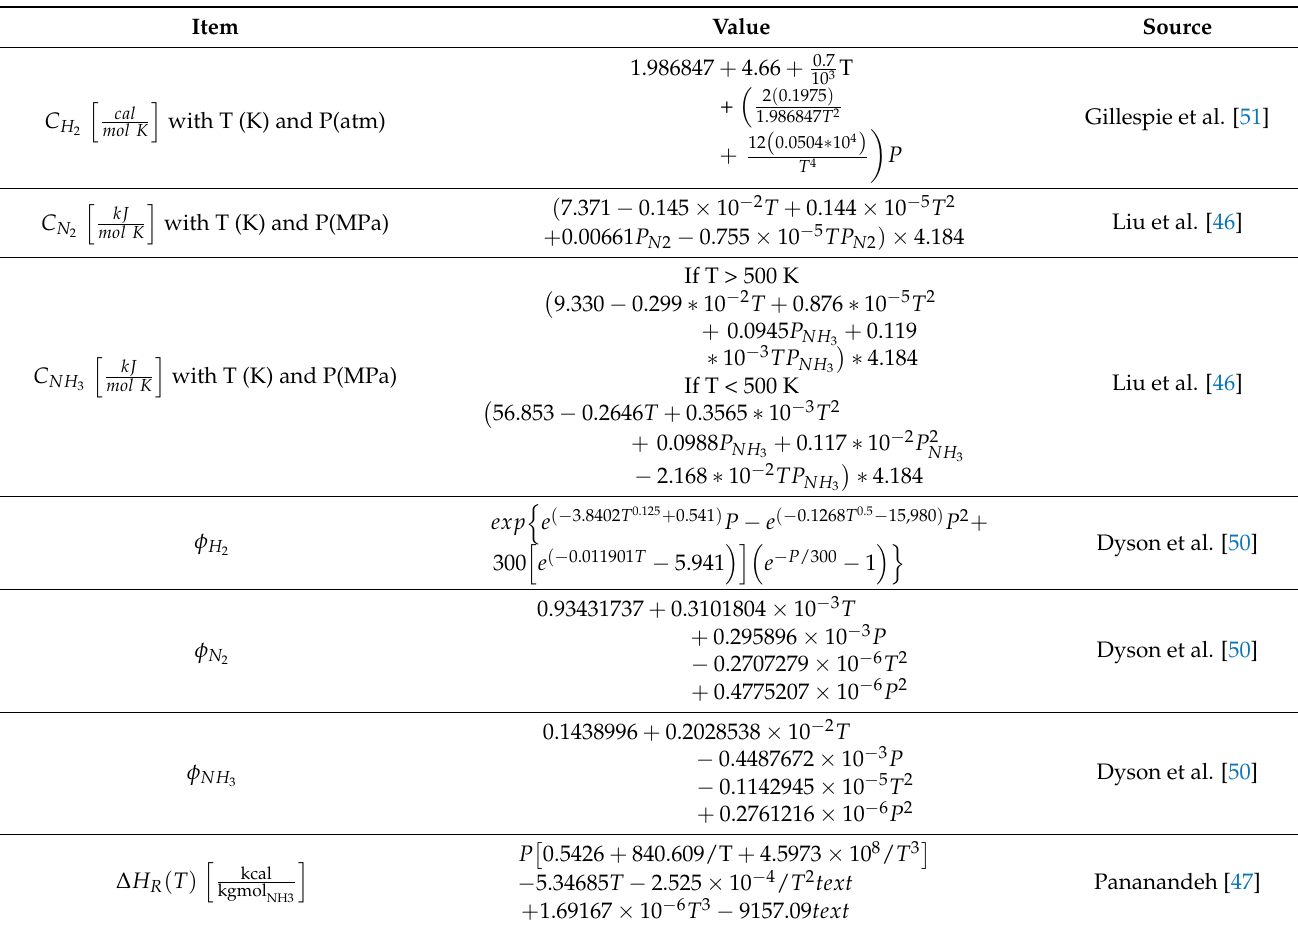
Table 2. Summary of Correlations used in Modelling the Synthesis